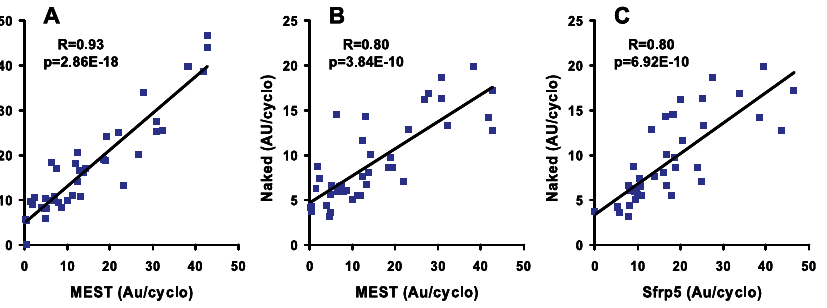
Figure 7. Coordinated Gene